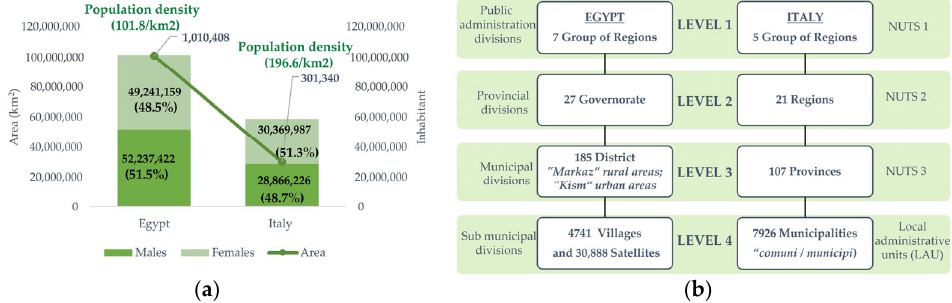
Figure 5. ( a ) Area, population by sex, and population density in Egypt and Italy (reference year 2021); ( b ) the administrative system hierarchy in Egypt and Italy, based on CAPMAS and ISTAT.